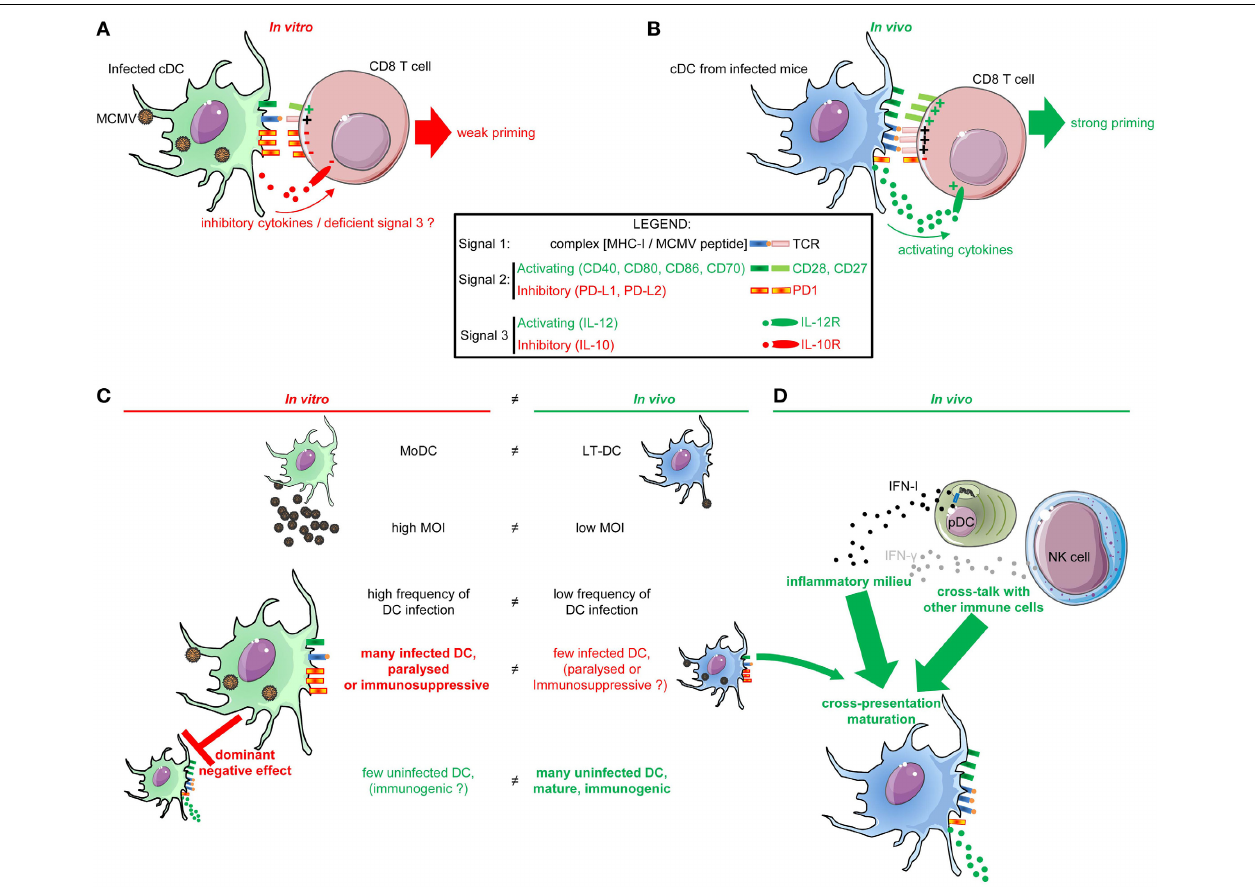
Specifically, XCR1 + DC and CD11b + cDC strongly up-regulate MHC and activating co-stimulation molecules in vivo , and can also produce T cell-activating cytokines such as IL-12 and IL-15. (C,D) Proposed explanations to the discrepancy of the impact of MCMV infection on DC in vitro vs. in vivo . (C) Impact of the nature of DC subsets and of their frequency of infection. The DC used in vitro are derived from monocytes (MoDC) and strongly differ from the DC involved in vivo in the induction of anti-viral immune responses in lymphoid tissues (LT-DC). High MOI are used for in vitro infection of DC, leading to a very high proportion of infected cells subjected to the effects of viral immune evasion genes. In contrast, only a very small fraction of XCR1 + cDC and CD11b + cDC is infected in vivo . (D) Protective functions of cDC in MCMV infected mice are promoted by the inflammatory milieu, in particular by IFN-I and IFN- γ , and by cross-talk with other immune